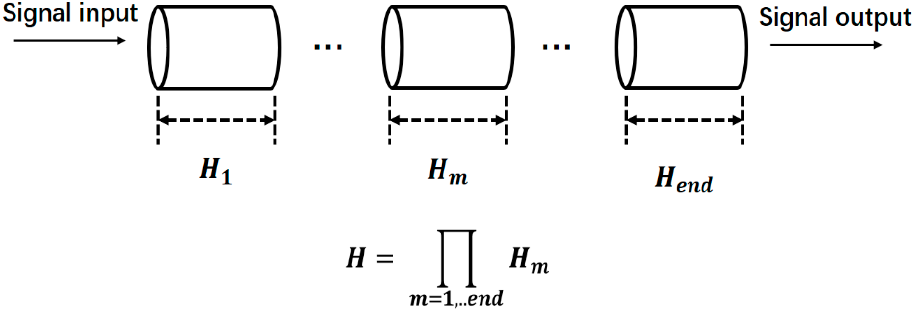
Figure 2. Model of the linear fiber transmission link.